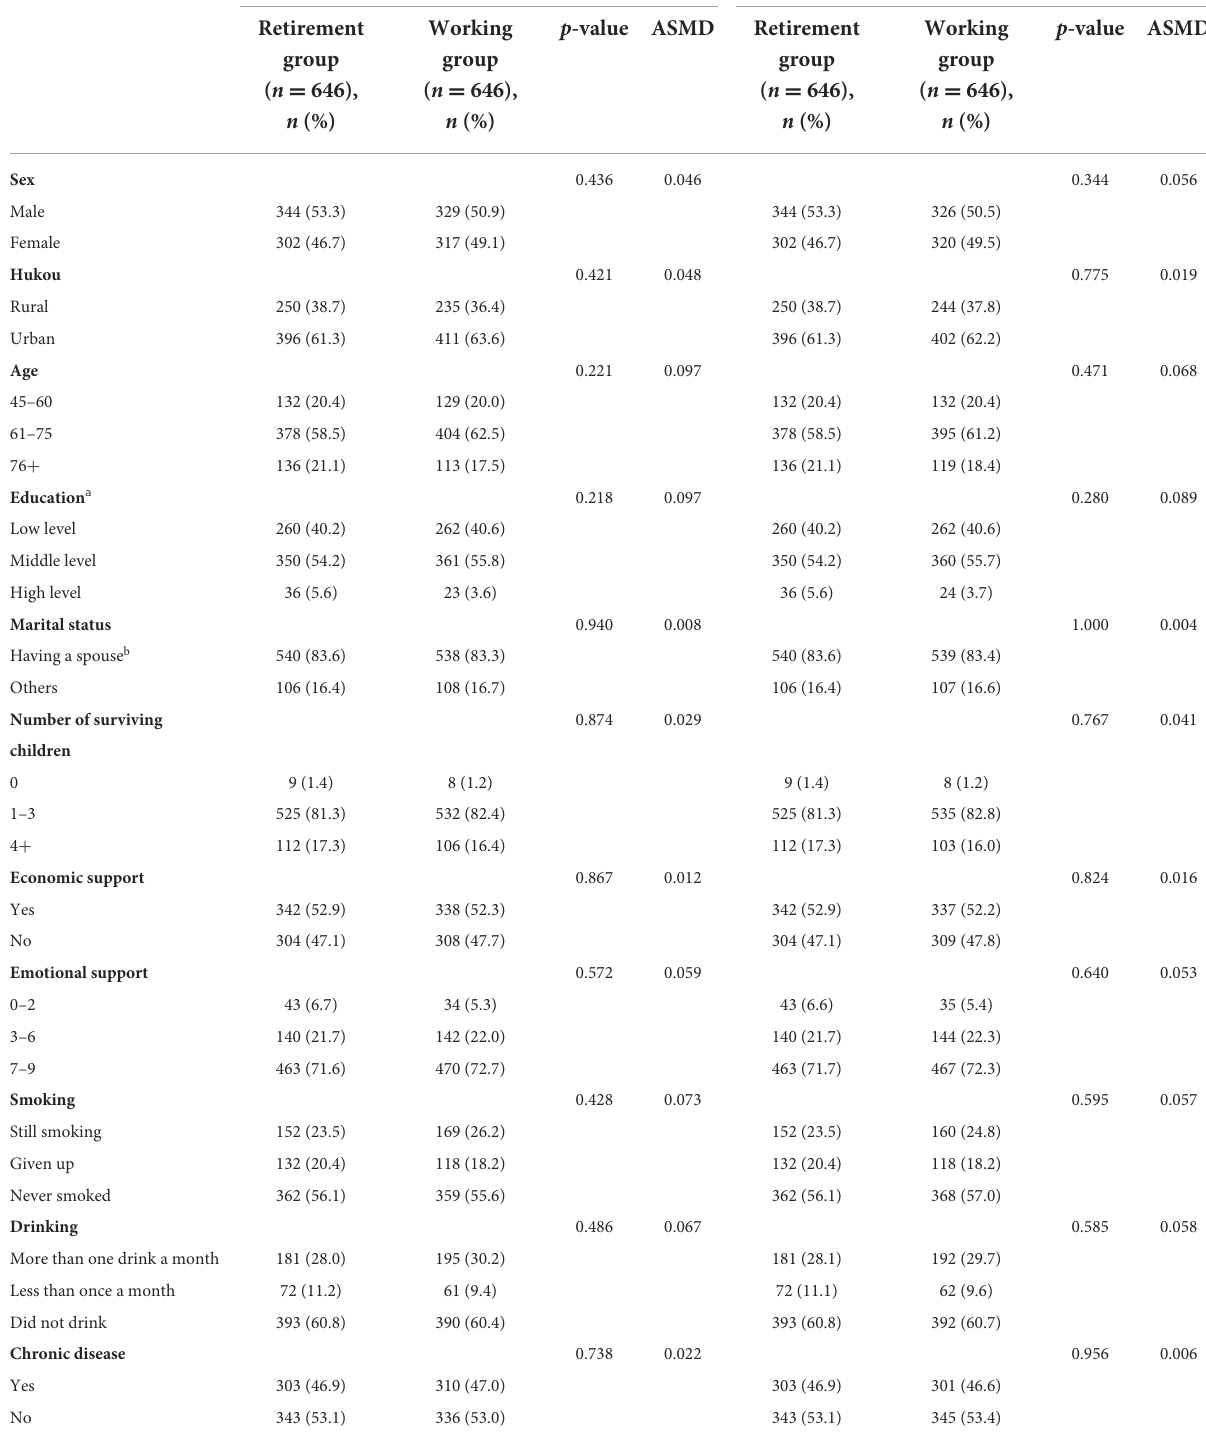
TABLE 2 Comparison of the baseline characteristics between the two groups after nearest neighbor matching and genetic matching based on the GBM. Covariates Nearest neighbor matching Genetic matching